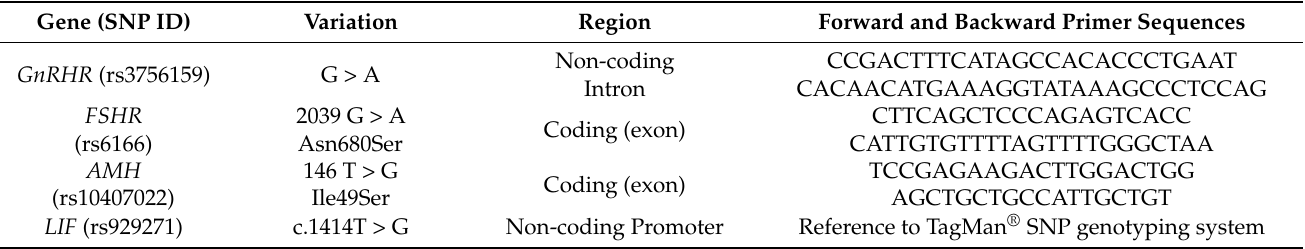
Table 1. Genetic variation and primer sequence for studied